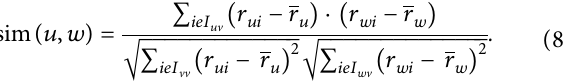
Figure 2: User similarity calculation